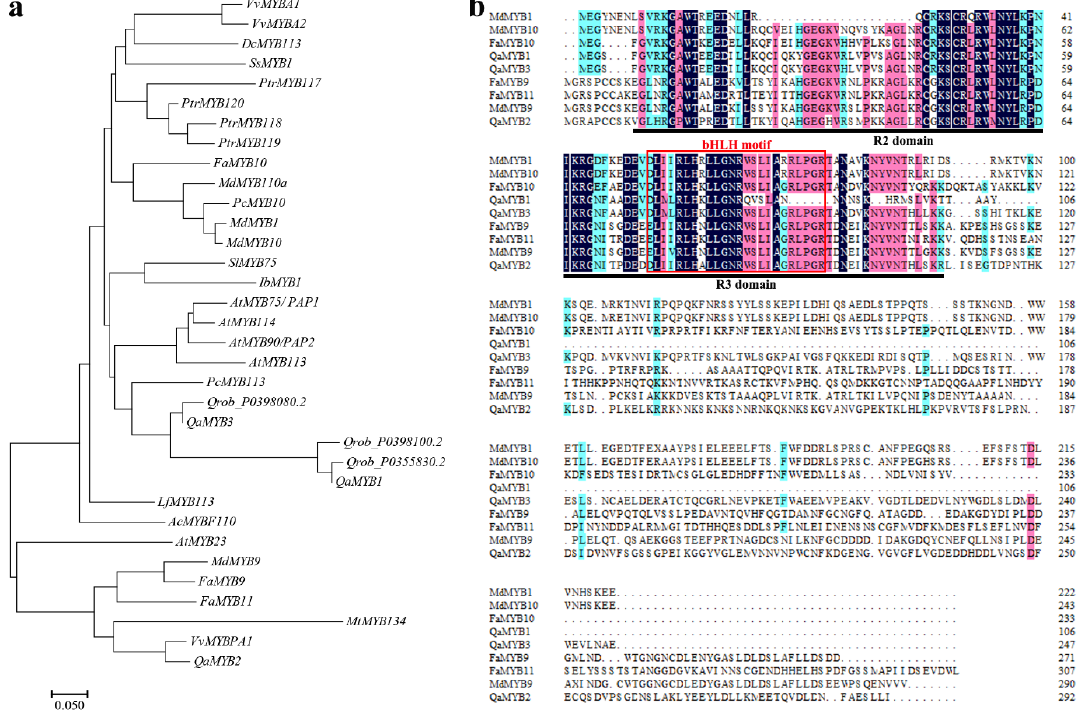
Figure 6. ( a ) Systematic evolution and ( b ) homology analysis of three MYB transcription factors in Q. aliena . Q. aliena